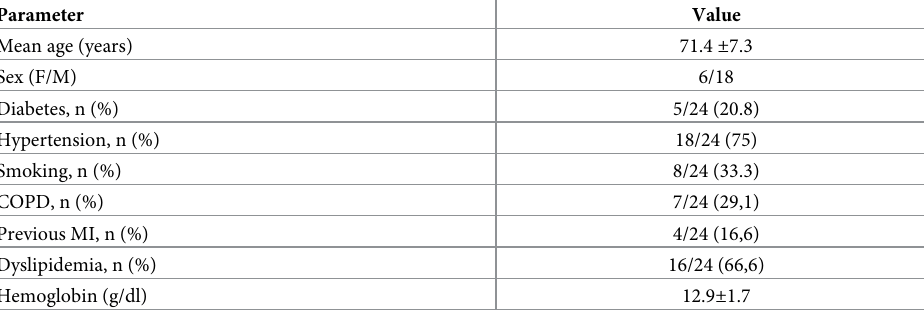
Table 1. Demographic and clinical characteristics of the study